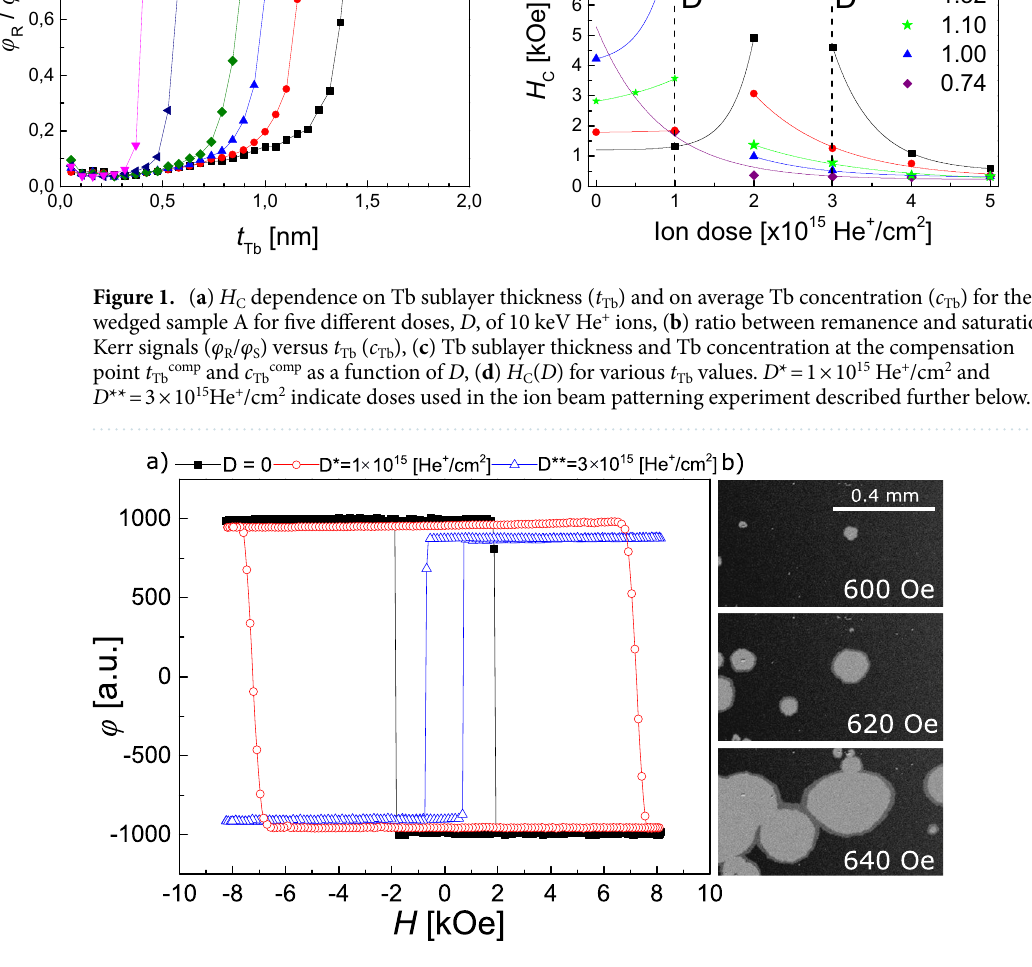
Figure 2b shows the evolution of the magnetic configuration within one of the reference areas (here the one bombarded by D **) for an increasing magnetic field ( H ). Low density of nucleation centers seen in the images (a few of them per mm 2 ) and the isotropic propagation of DWs provide evidence for the lateral homogeneity of the layers and the small defect density, not only in protected areas, but in bombarded regions as well. Similar results have been obtained also for all other reference areas in the as deposited samples as well as in those bombarded with different doses.